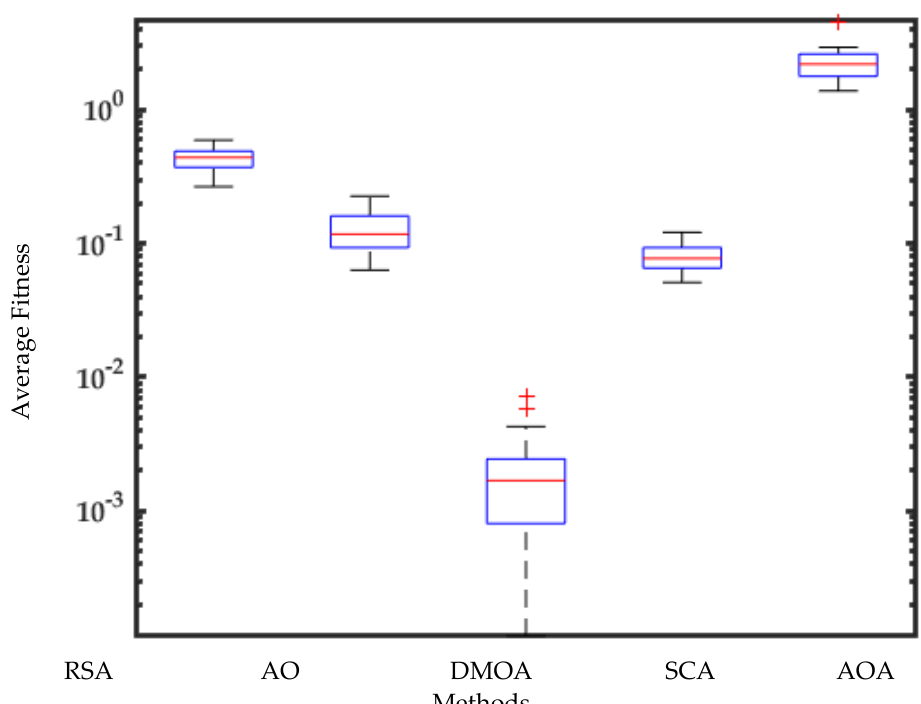
Figure 7. Boxplot analysis of the DMOA along with the AO, AOA, RSA and SCA.